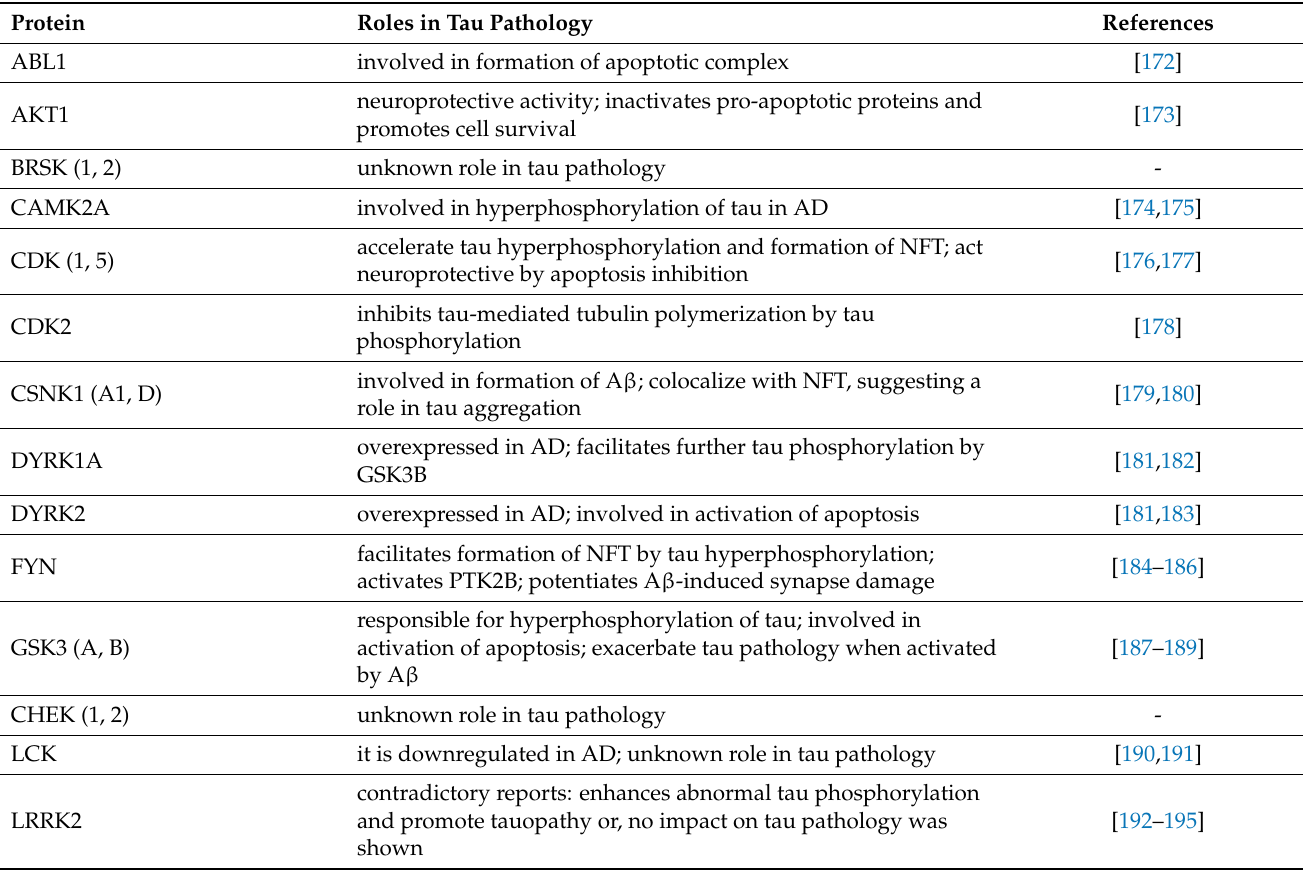
Table 2. Overview of protein kinases interacting with tau protein and their roles in pathology. Protein Roles in Tau